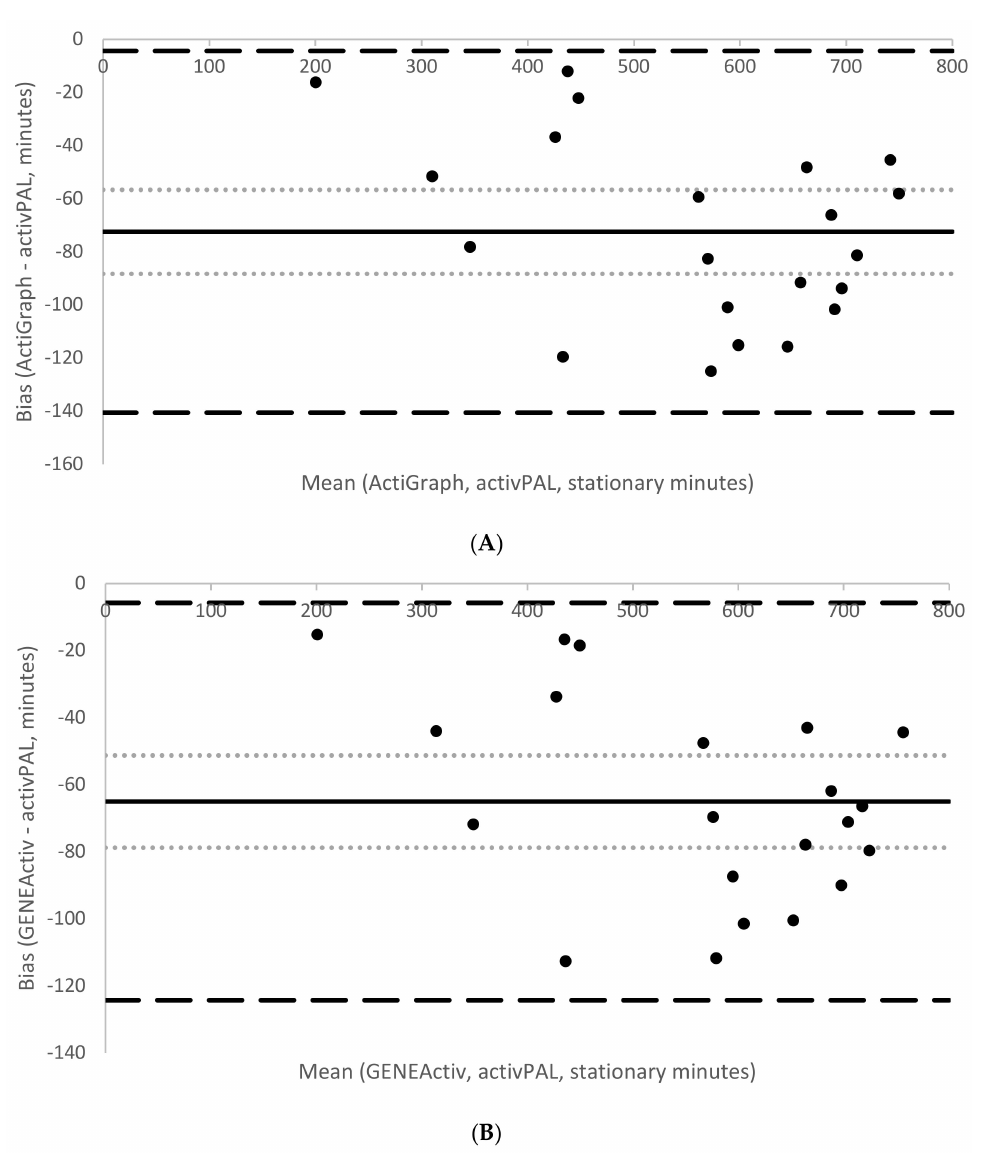
Figure 2. Mean bias (solid line), 95% CI of the mean bias (light dotted lines) and 95% limits of agreement (large dashed lines) for the stationary free-living time estimated by the developed thresholds for ActiGraph non-dominant wrist ( A ) and GENEActiv non-dominant wrist ( B ) relative to